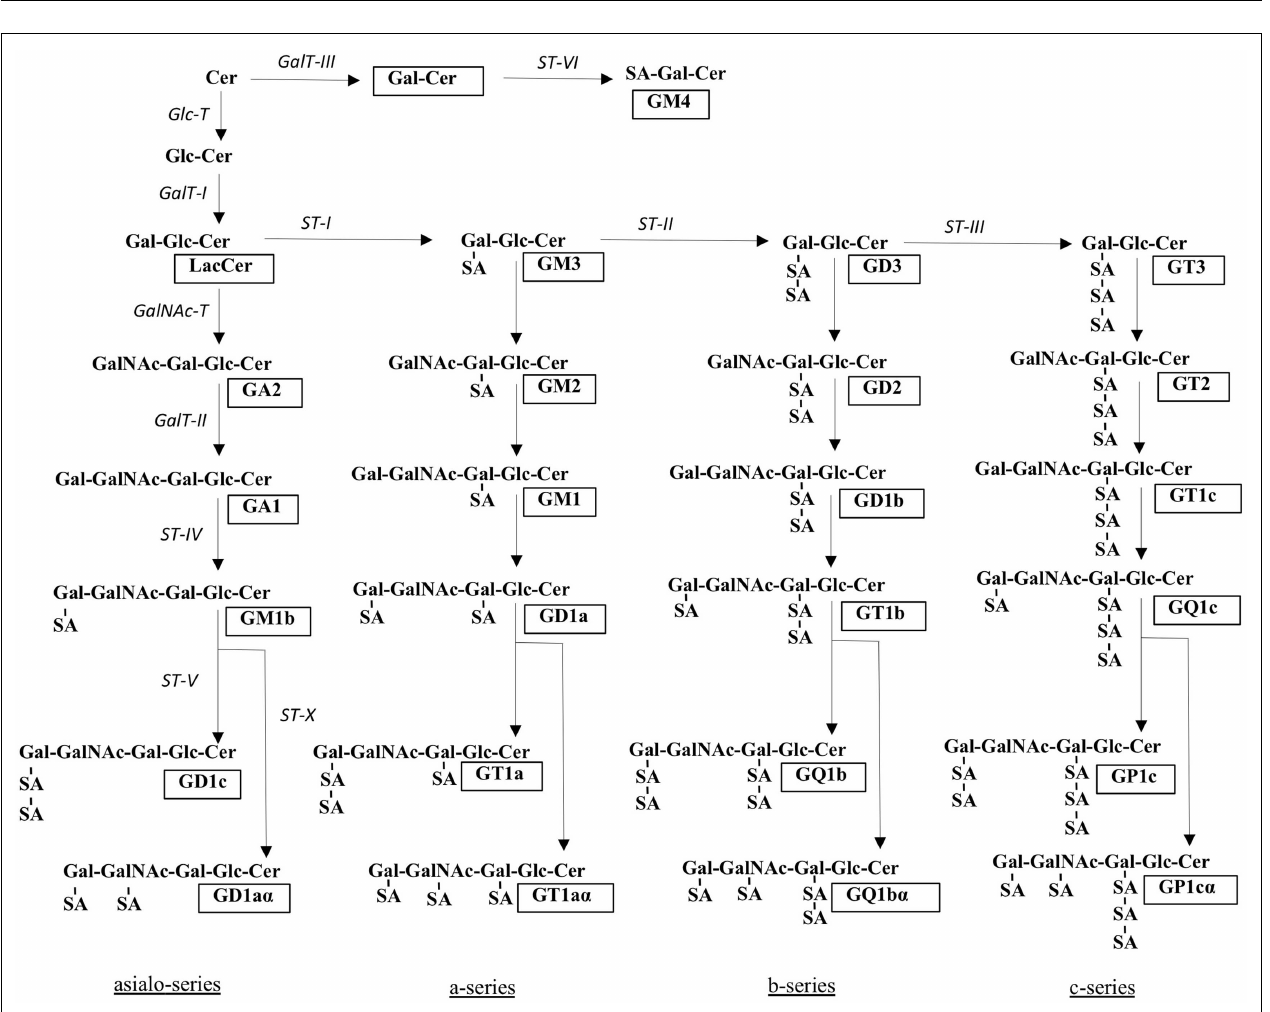
FIGURE 2 | Structures and biosynthetic pathways of gangliosides .The glycosyltransferases catalyzing the synthesis of gangliosides are shown in italics. Cer, ceramide; SA, sialic acid. Ganglioside nomenclature [according to Svennerholm (1)] is shown in boxes. Adapted from Ref. (5).